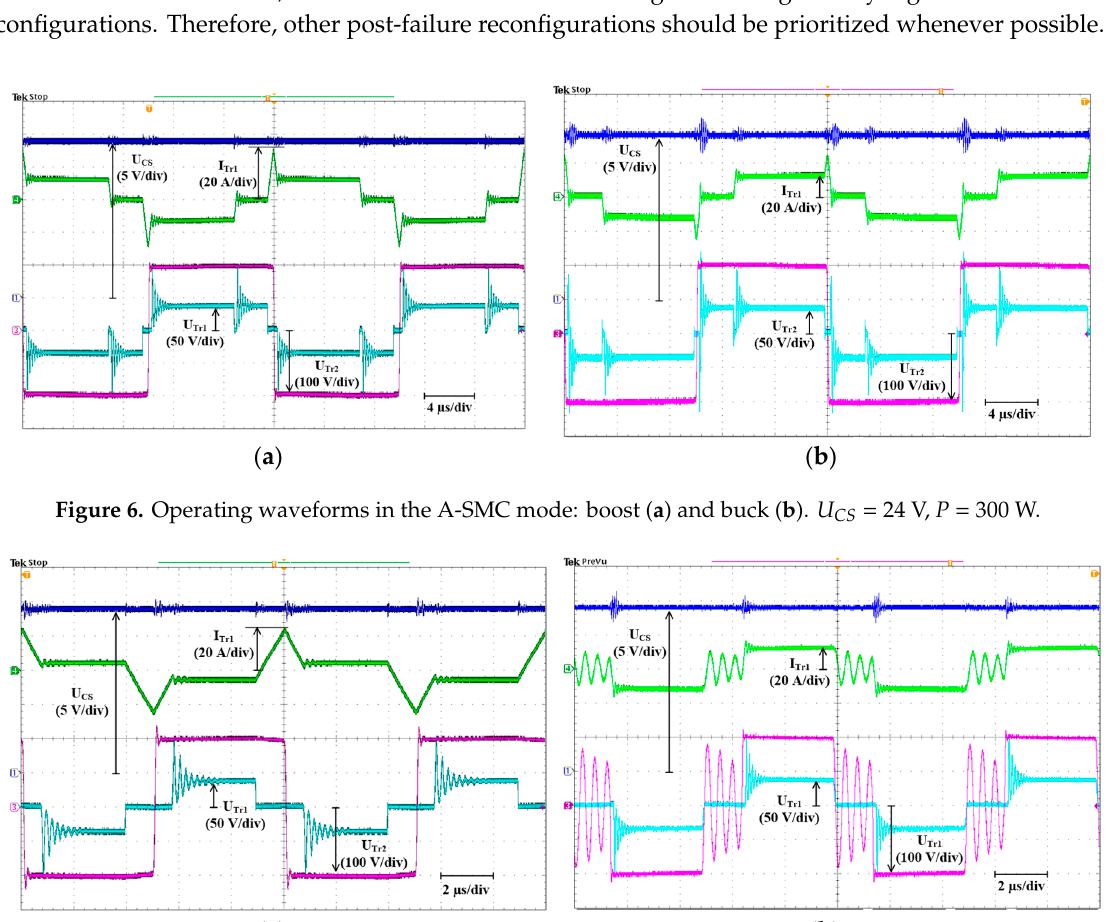
= 24 V, P = 300 W. CS